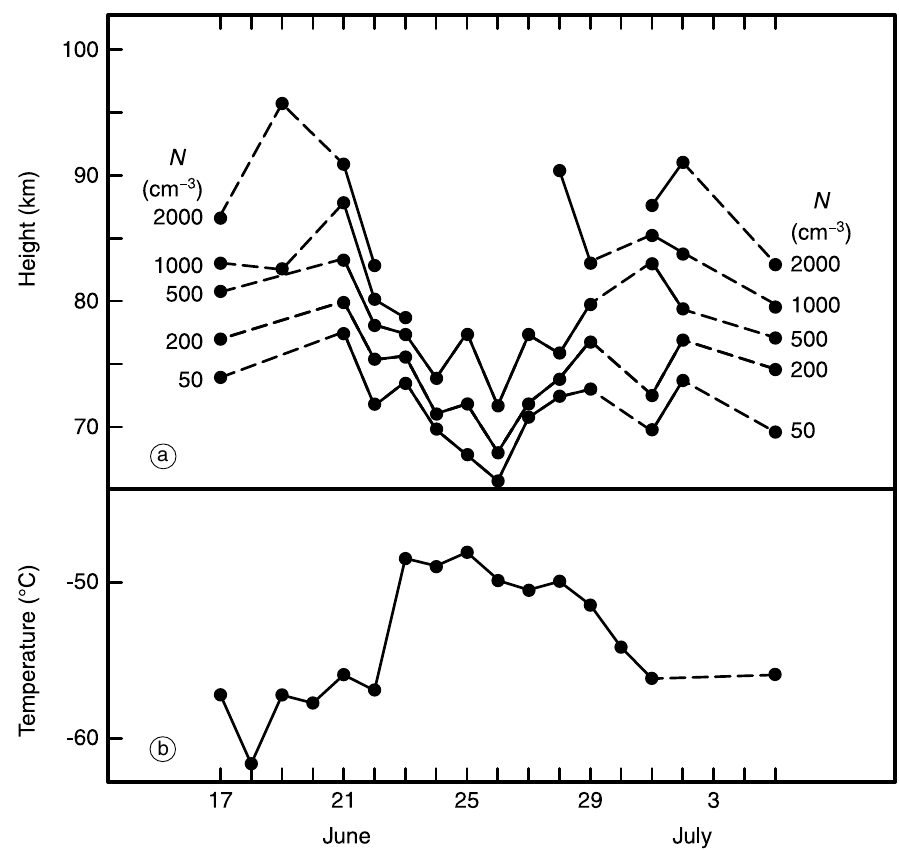
Fig. 4a,b. Ionospheric D -region changes accompanying a winter stratospheric warming in June and July 1963, at Christchurch, New Zealand, 43 ° S, 173 ° E. a) Noon electron concentration N; b) stratospheric temperature at 20-30 mbar level (about 25 km altitude) (Gregory and Manson,